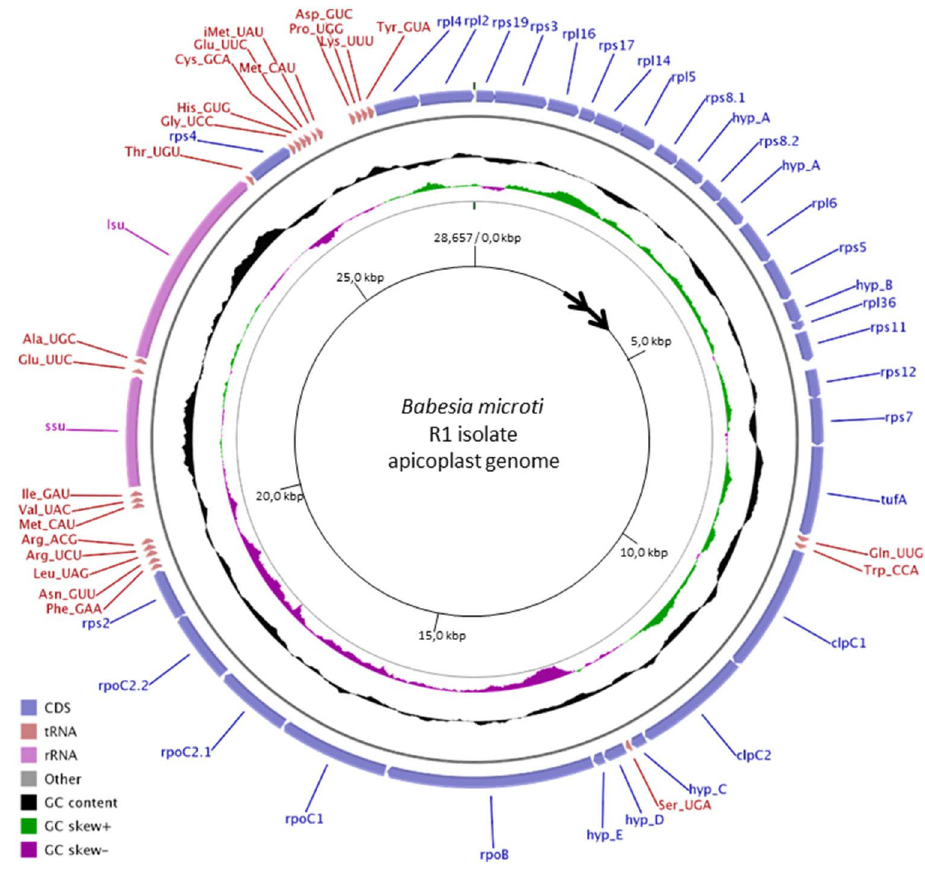
Figure 1. Graphical circular map of the apicoplast genome of B.microti R1 isolate. The map was designed using CGview and GenomeVx. From outside to center: coding sequence (CDS), % G + C, GC skew and base coordinates. hypA-E refer to five hypothetical protein encoding genes found in the apicoplast genome of B. microti .